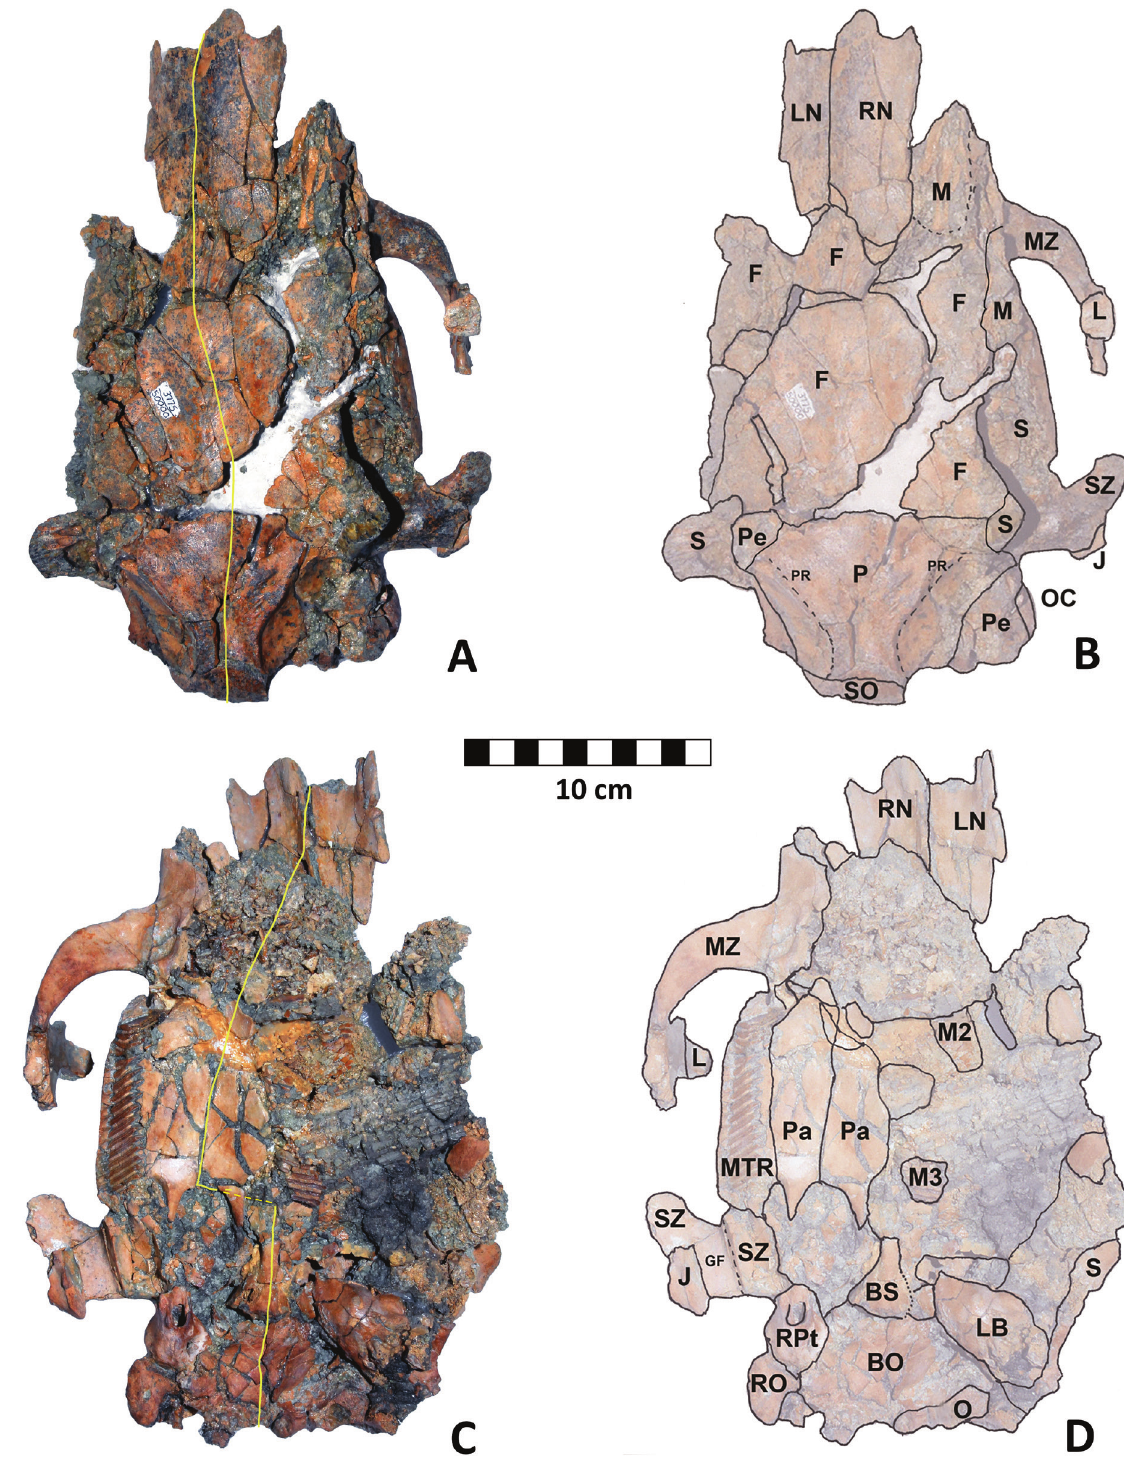
Figure 5. SDSNH 50000. A, B: dorsal view; C, D: ventral view. In B and D, the boundaries of the bones are approximations, as the crushed condition of the skull prevented determining actual suture lines in many cases. Abbreviations: BO, basioccipital; BS, basisphenoid; F, frontal; GF, glenoid fossa; J, jugal; L, lachrymal; LB, left auditory bulla; LN, left nasal; M, maxilla; MTR, maxillary tooth row; MZ, zygomatic process of maxilla; M2, fragment of second upper molar; M3, fragment of third upper molar; O, occipital; OC, occipital condyle; P, parietal; Pa, palatine; Pe, petrosal; PR, parasagittal ridge; RN, right nasal; RO, right occipital condyle; RPt, right petrosal; S, squamosal; SO, supraoccipital; SZ, zygomatic process of squamosal. Unlabeled areas are either fragments of bone which could not be allocated to a specific element, areas of crushed and comminuted bone, matrix, or are gaps between bones where fragments have separated or are